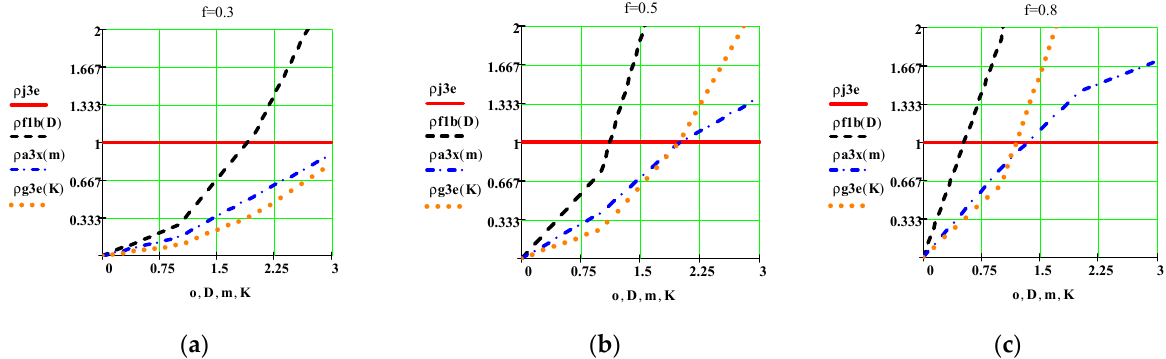
Figure 3. IFD values plotted based on the relationships (9), (14), (20) and (24) for different values of the normalized modulation signal power f 2 ( t ) : ( a ) 0.3; ( b ) 0.5; ( c )